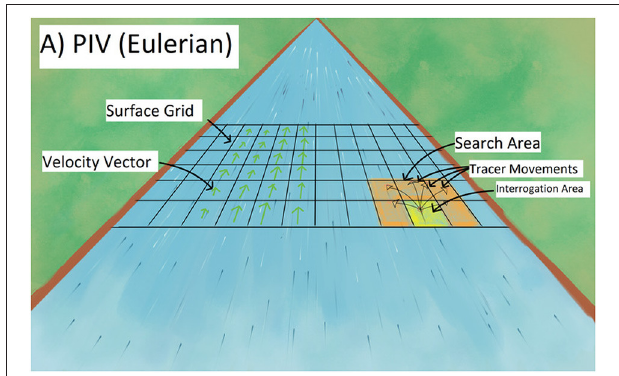
FIGURE 11 | Schematics of general PIV (A) mechanics.